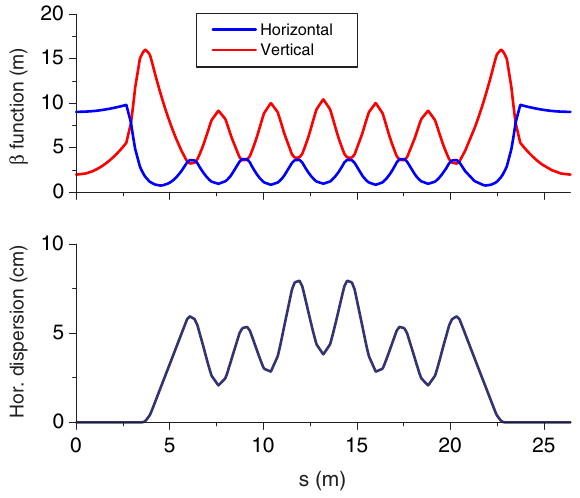
FIG. 3. Lattice functions of the seven-bend-achromat cell of MAX IV 3 GeV storage ring. The ring is composed of 20